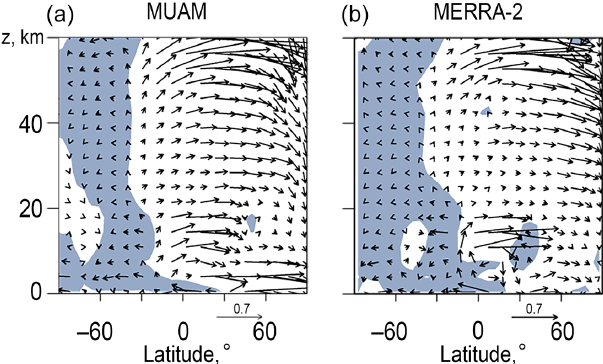
Figure 2. Latitude–altitude distributions of the RMC wind vectors averaged over 19 MUAM runs (a) and according to the MERRA- 2 reanalysis data (b) for January. Areas with negative (southward) residual meridional wind are shaded with the grey-blue colour. The vectors are shown for the vertical velocity multiplied by a factor of